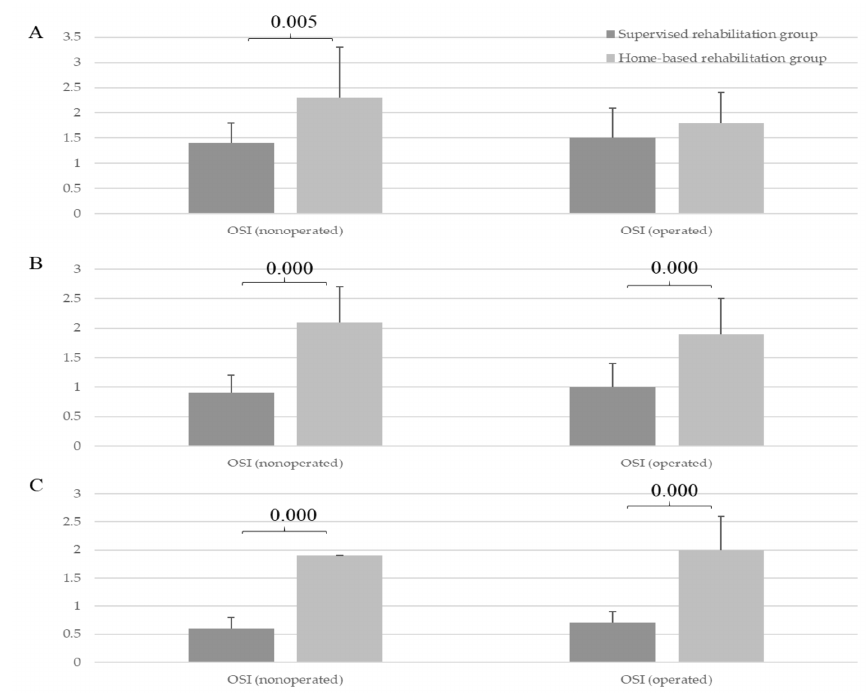
Figure 3. Comparison of dynamic postural stability (overall stability index, OSI) in operative and nonoperative knees between the supervised rehabilitation group and home-based rehabilitation group. ( A ) Preoperative baseline, ( B ) At postoperative 6 months, and ( C ) At postoperative 1 year.